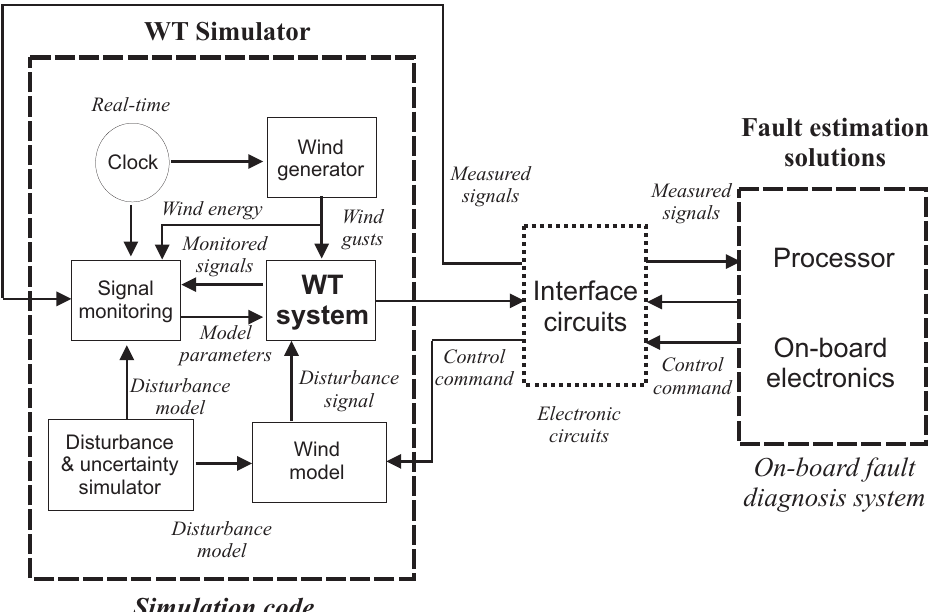
Figure 7. HIL tool for real-time validation.